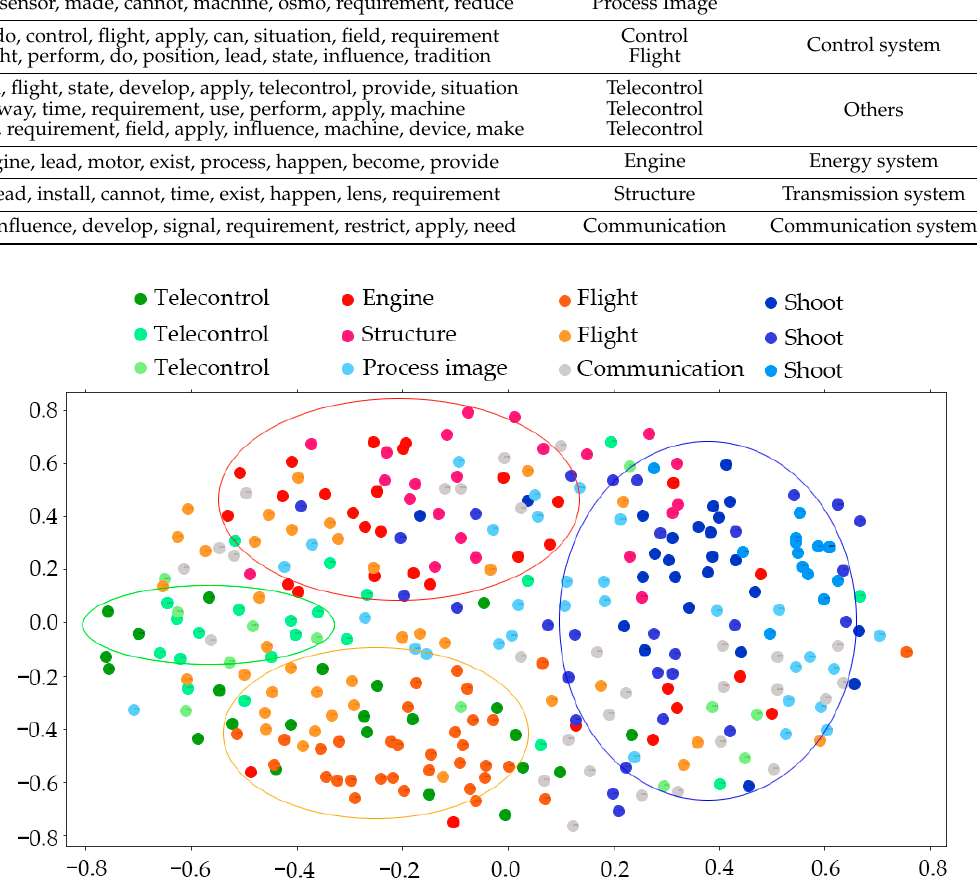
Figure 13. Result of K-means clustering. Table 3. Top 10 keywords of the 12 clusters, and the possibility distribution of six R&D themes. Top 10 Keywords Function of UVA R&D Themes